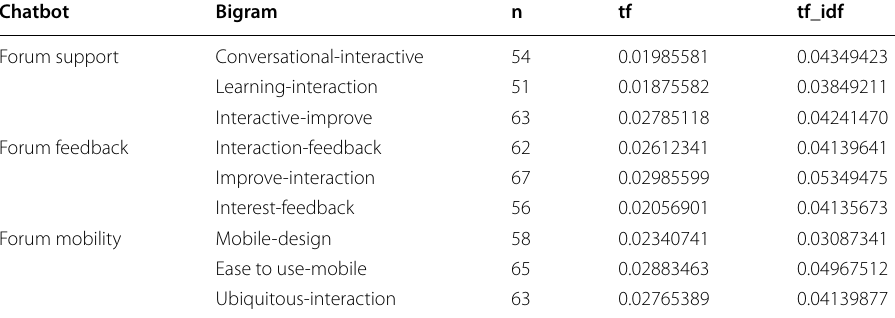
Table 6 Forum bigrams